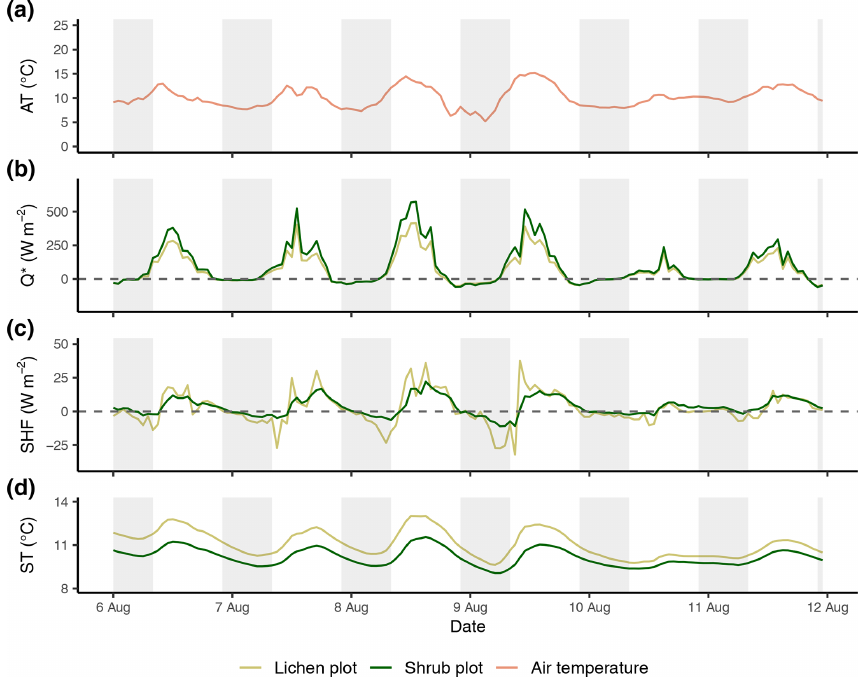
Figure E3. Time series of the reference air temperature (a) , net radiation (b) , soil heat flux (c) and soil temperature (d) between the third set of paired plots of the field season of 2019. Time series are constructed with hourly averages. Shaded areas indicate nighttime (22:00–08:00LT). AT: reference air temperature; Q ∗ : net radiation; SHF: soil heat flux; ST: soil temperature.